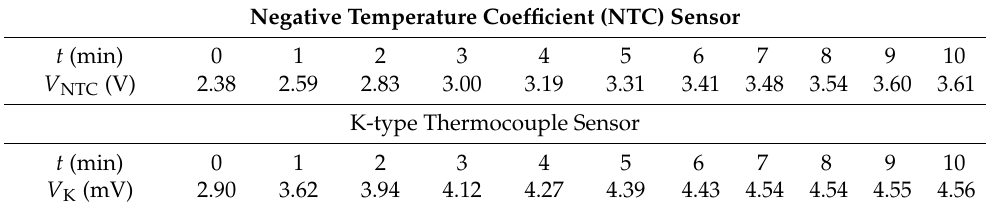
Table 2. Measured points of the step